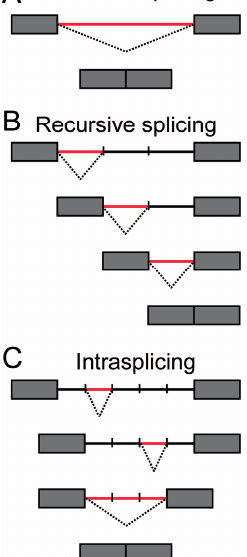
Figure 3. Schematic representation of canonical- ( A ), recursive- ( B ), and intra- ( C ) splicing. Boxes and lines are exons and introns, respectively. Splicing processes are shown by dotted